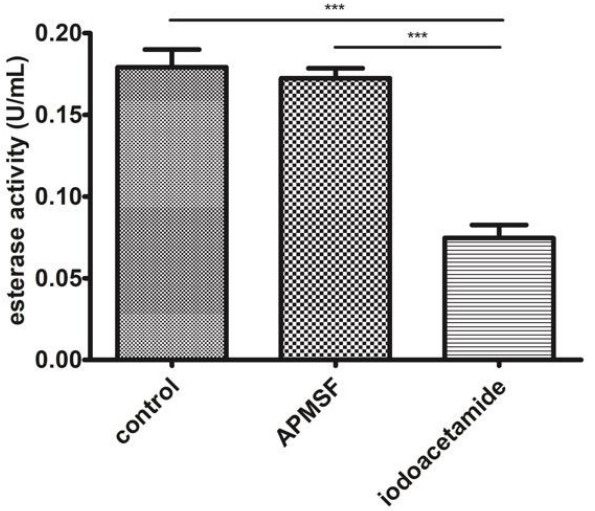
Figure 4. Esterase activity analysis in the EtOH 50–80% fraction with serine (APMSF) and cysteine (iodoacetamide) ester- ase inhibitors. *** p < 0.001.